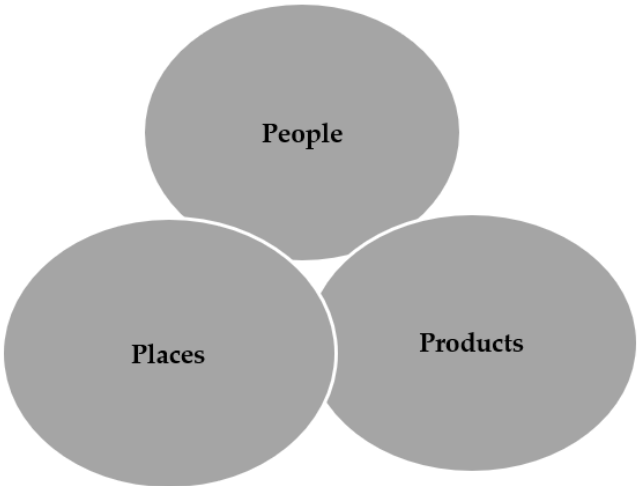
Figure 1. Linking people, places and products to valorise GIs. Source: Own elaboration based on Vandecandelaere et al. [17].